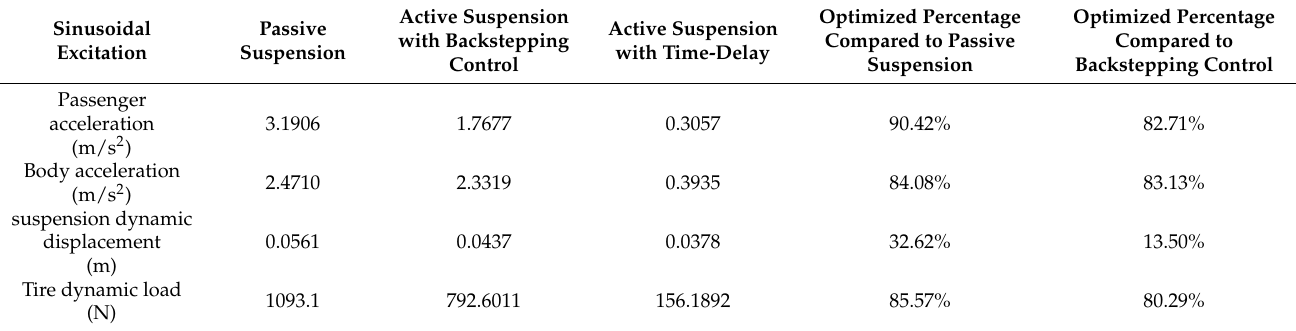
Table 3. Suspension performance root mean square value comparison